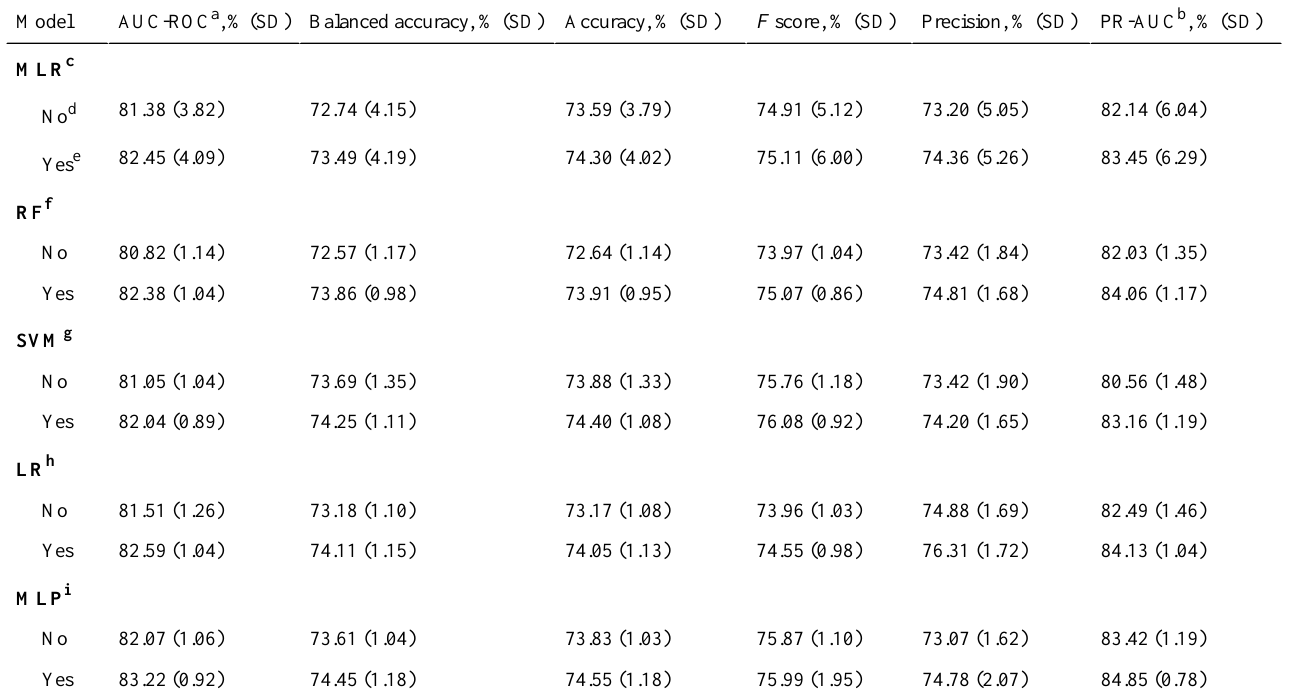
Table 3. Classifiers performance for current glycated hemoglobin level prediction.